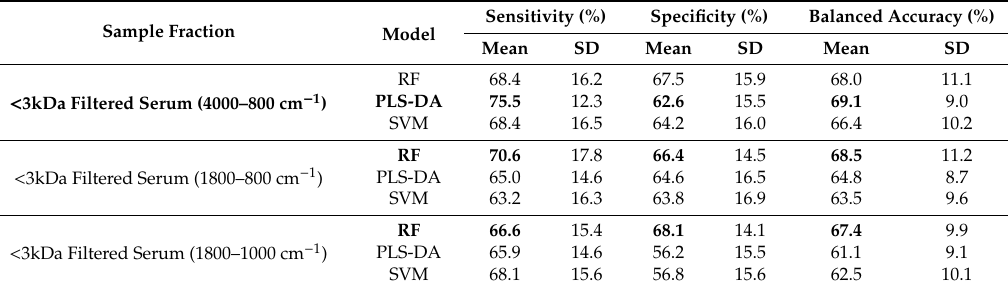
Figure 9. Examples of whole serum (bottom), the high molecular weight concentrate (middle) and the Table 5. Classification results for the IDH1 -mutated versus IDH1 -wildtype serum datasets after 100 low molecular weight filtrate (top) spectra. Raw spectra offset for clarity. resamples. The mean sensitivity, specificity and balanced accuracy are reported with their corresponding